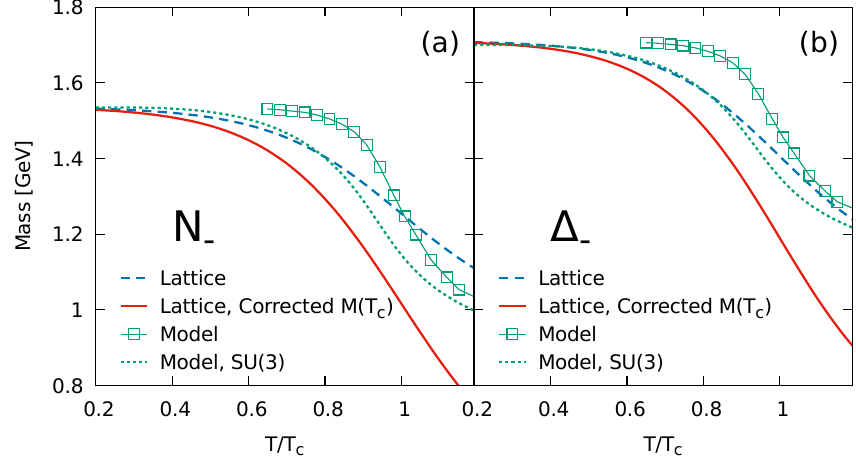
Figure 1. Temperature dependence of the non-strange baryons with negative parity:( a ) for N − ; and ( b ) for ∆ − , for the assignment C in Table 1.